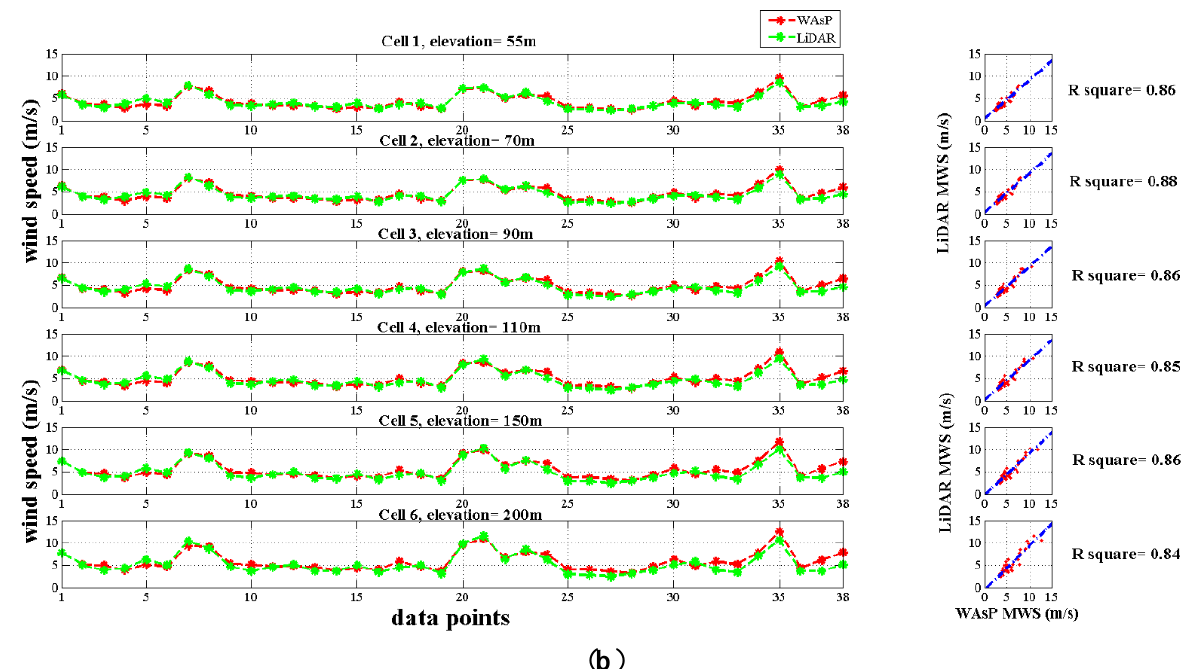
Figure 8. WAsP-simulated result versus Lidar field measured data (left: time sequence; right: regression analysis). ( a ) Miaoli region; ( b ) Tainan